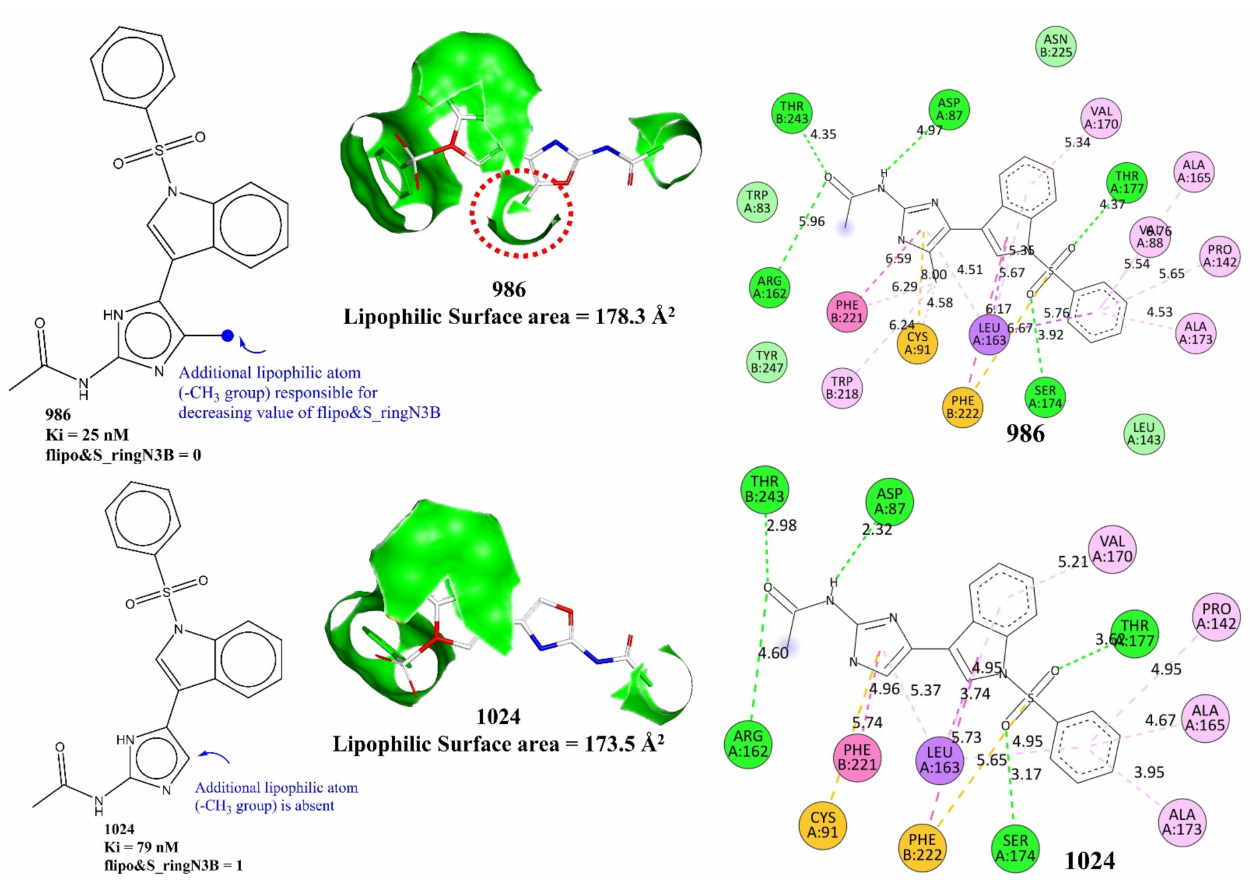
Figure 5. Representation of flipo&S_ringN3B using molecules 986 and 1024 as examples. The green contour in the middle figures depicts the lipophilic surface